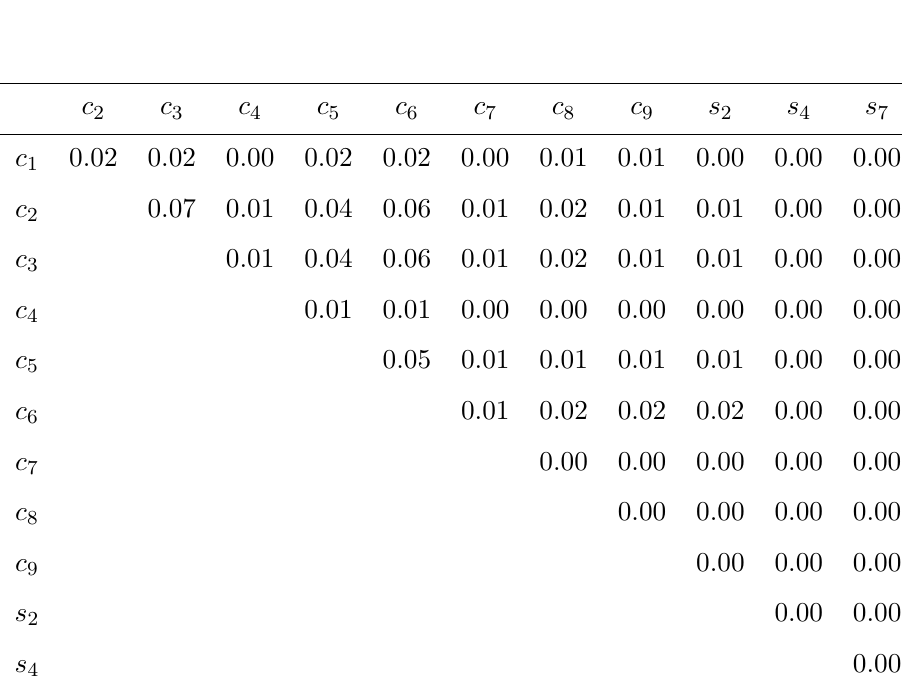
Table 11 . Systematic correlation coe(cid:14)cients between c i and s i